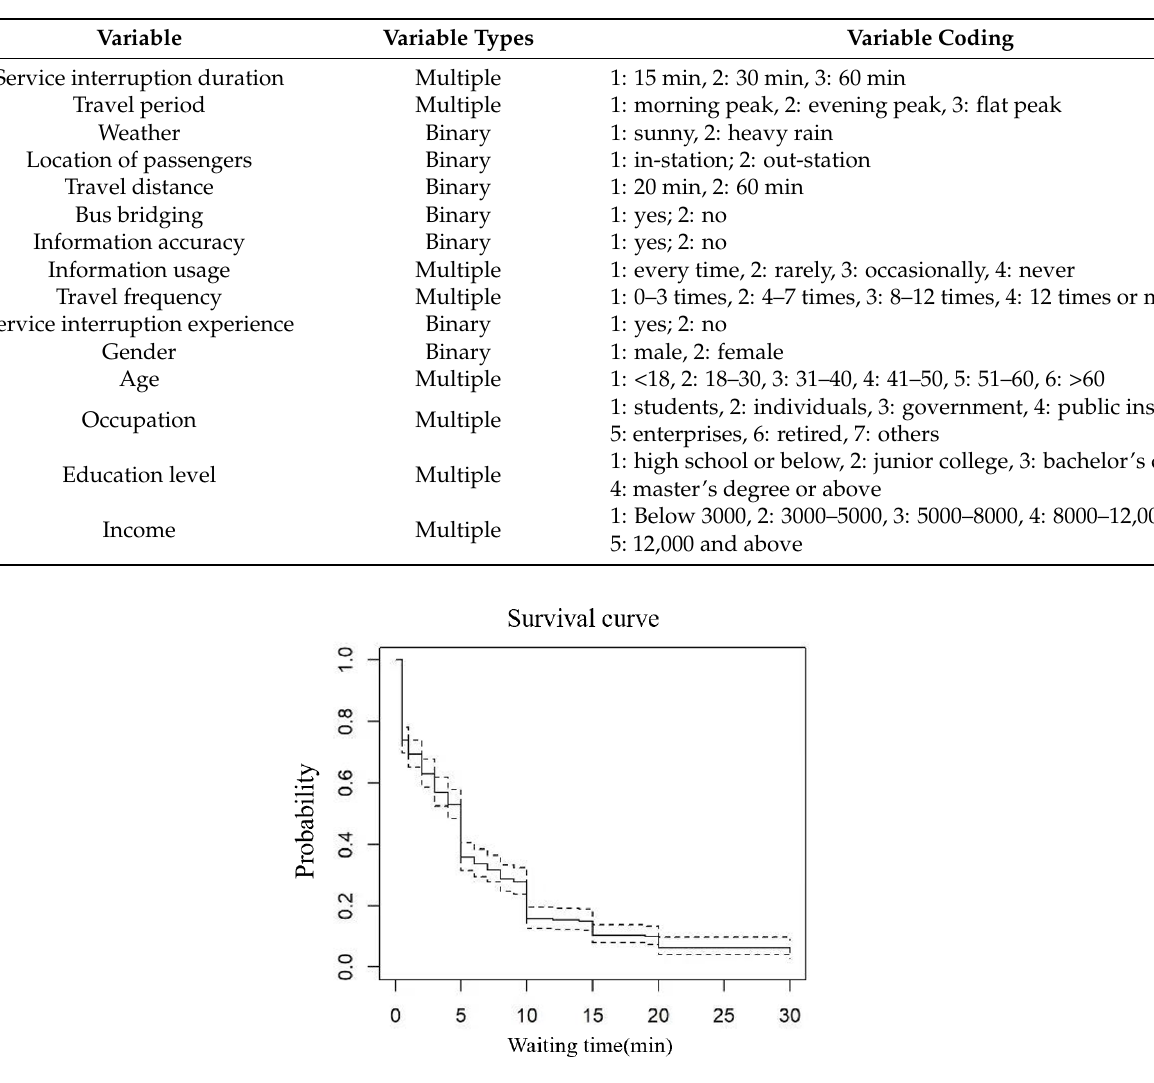
Table 9. Coding description of the influencing factor variables.